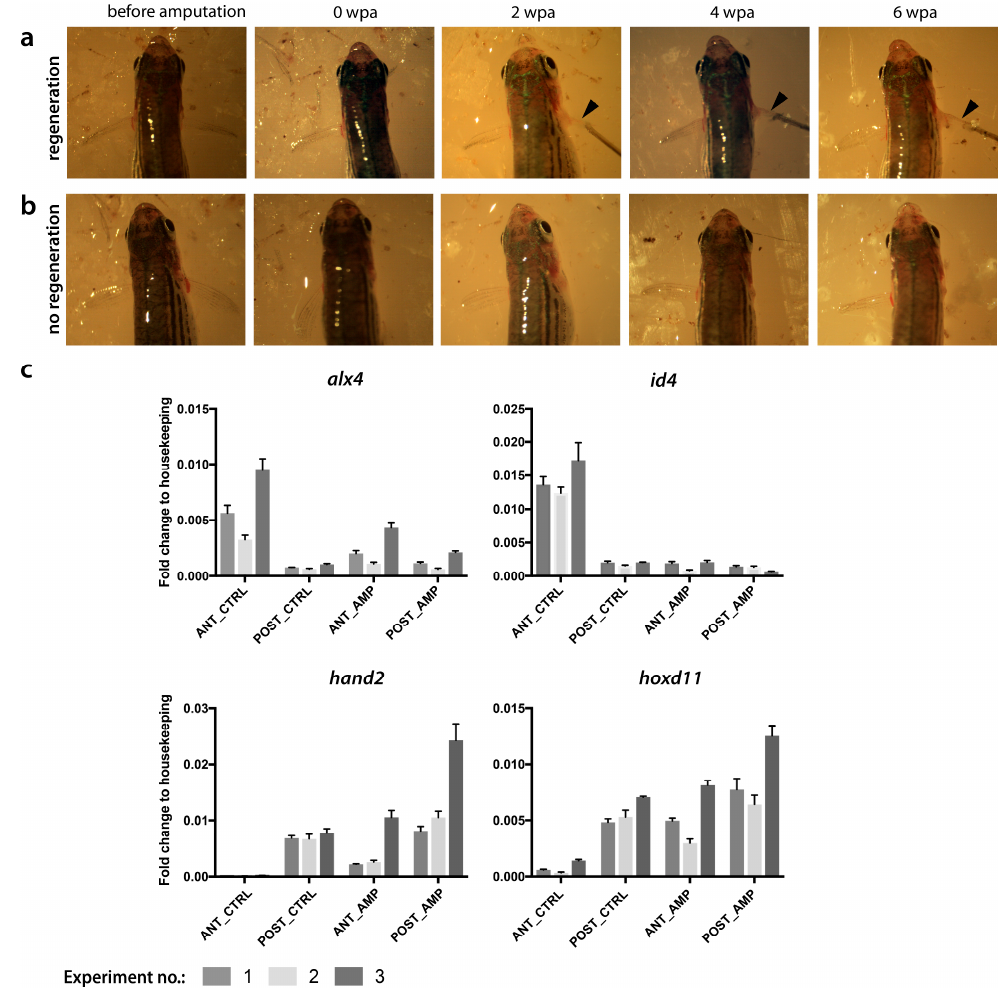
Figure A1. Impaired regeneration of the zebrafish pectoral fin following endoskeletal amputation. ( a ) In individuals where a regenerated fin could be seen at 6 wpa a visible regenerate was already observable at 2 wpa (black arrowhead). ( b ) Absence of regenerated fin at 2 wpa was indicative for the general failure in regeneration. ( c ) Gene expression measured by RT-qPCR of alx4 , id4 , hand2 and hoxd11 in anterior and posterior parts of control and regenerated fins (Error bars show variation between technical replicates). Results suggest that regenerated fins have an overall “posterior-like” character. Data for three biological replicates are shown, expression values are normalized to β -actin .